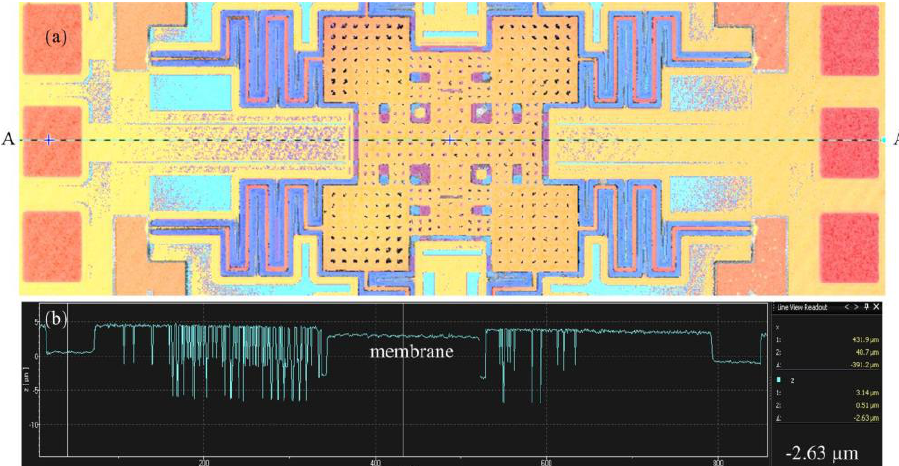
Figure 11. RF switch with annealing: ( a ) top view image; ( b ) profile along AA cross-section.